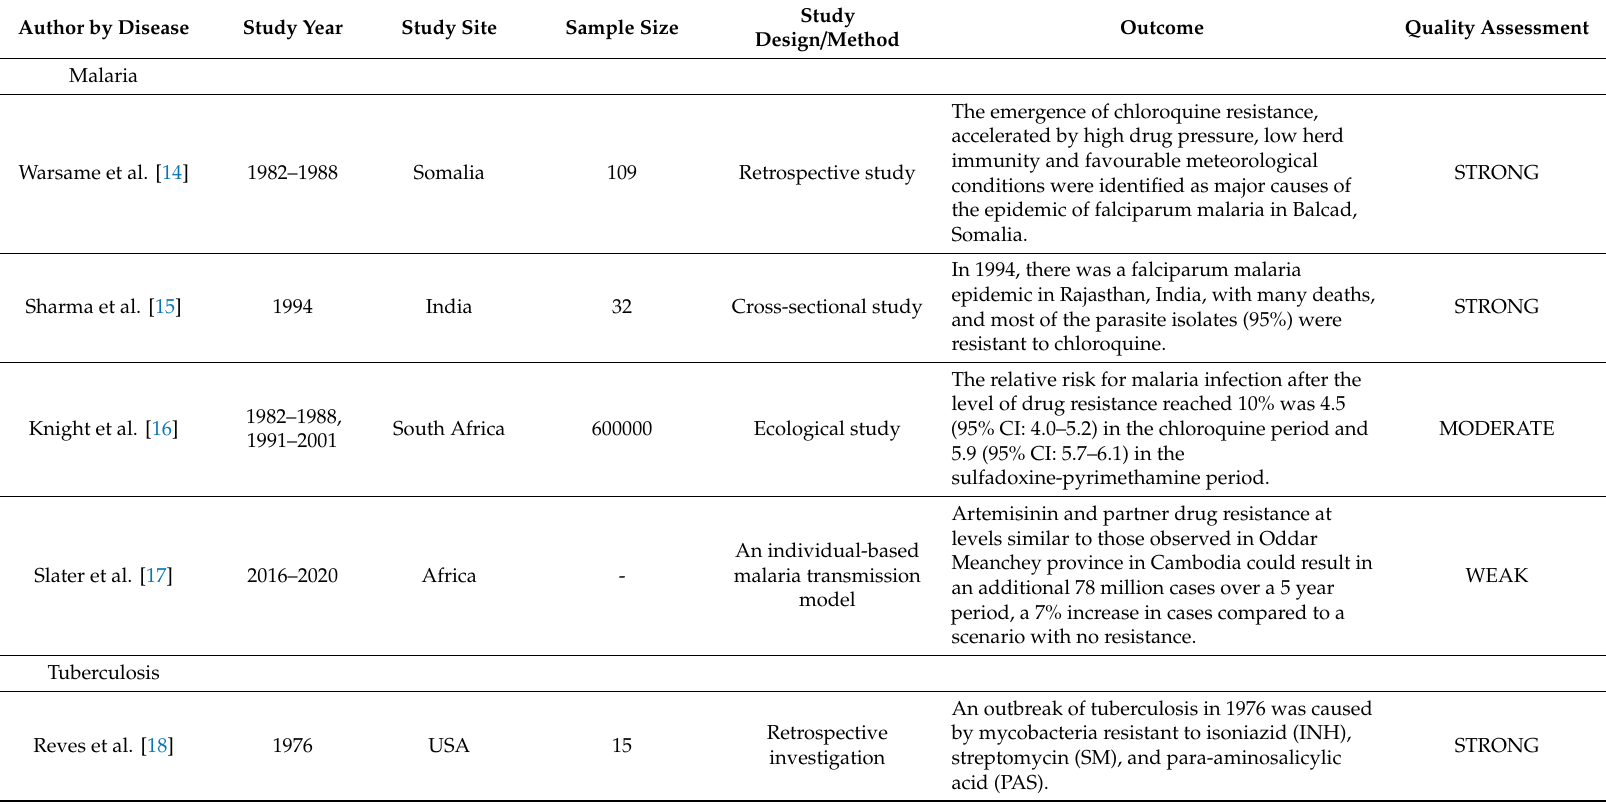
Table 1. Characteristics of included studies on public health outcomes due to